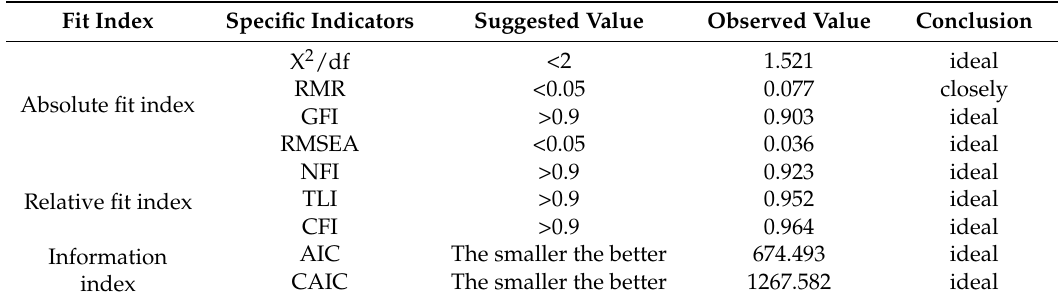
Table 6. Overall fitness evaluation standard and fitting evaluation result of structural equation